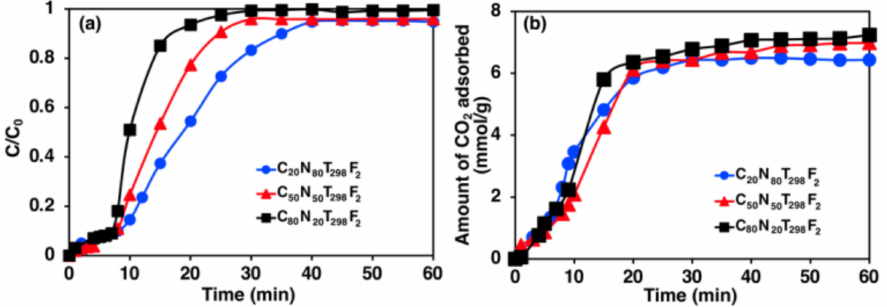
Figure 2. Effect of CO 2 composition on CO 2 adsorption at 298 K and feed flow rate of 2 L/h, which listed as: ( a ) breakthrough curves; ( b ) adsorption capacity.